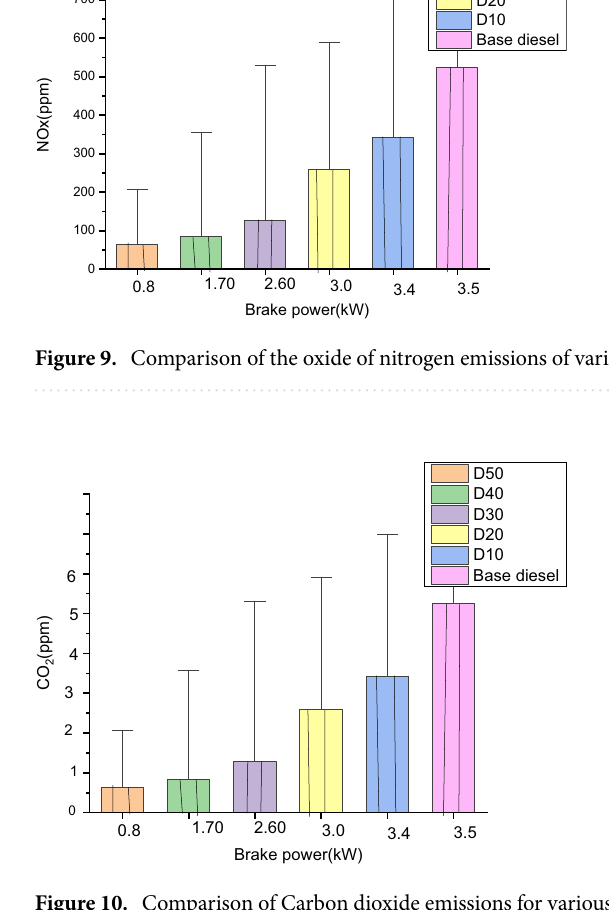
Figure 10. Comparison of Carbon dioxide emissions for various blends.